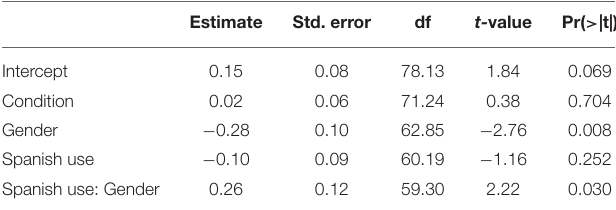
TABLE 4 | Results of LME on DFPT by target gender, condition, and Spanish use in the pause region. Estimate Std. error